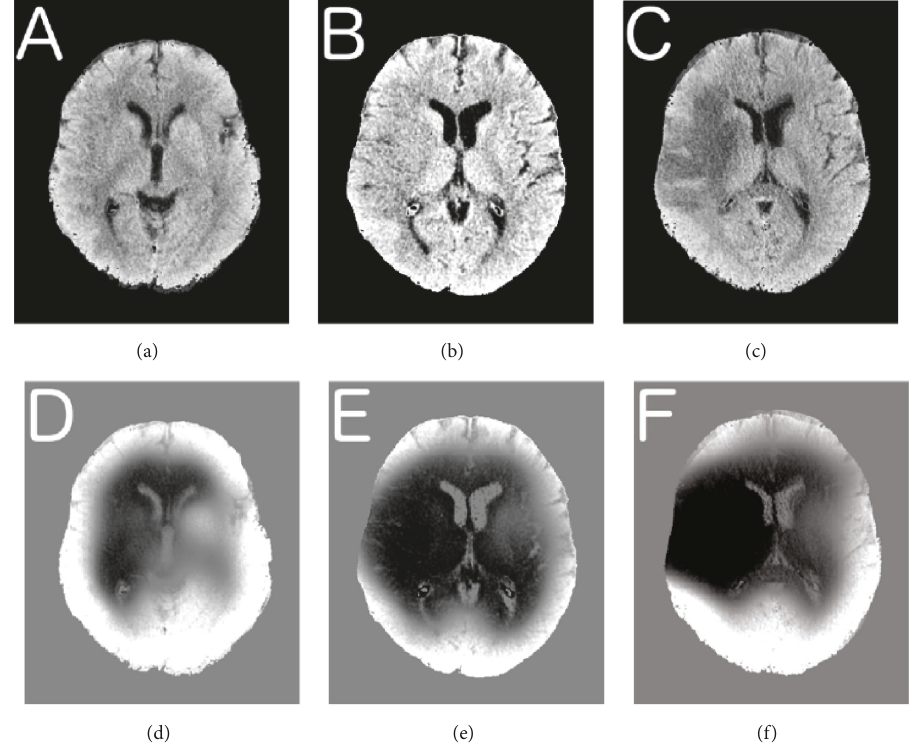
Figure 4: Time series images. Initial brain extracted image at 2.5 hours after symptom onset (a), at 5 hrs (b), and at 28 hrs (c). Corresponding thresholded difference maps (d–f). Stroke volumes were estimated (FSL) 12cc, 81.4cc, and 117.9cc as the infarct